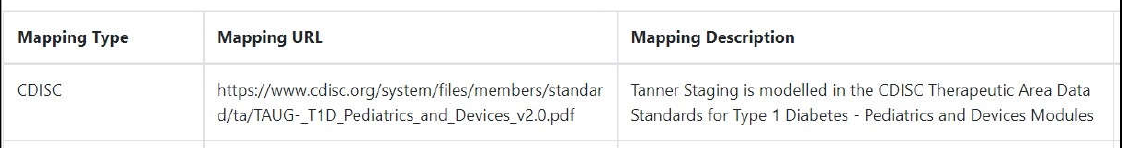
Figure 6. Image showing the CDISC mapping uniform resource locator (URL) and description. CDISC—Clinical Data Interchange Standards Consortium.